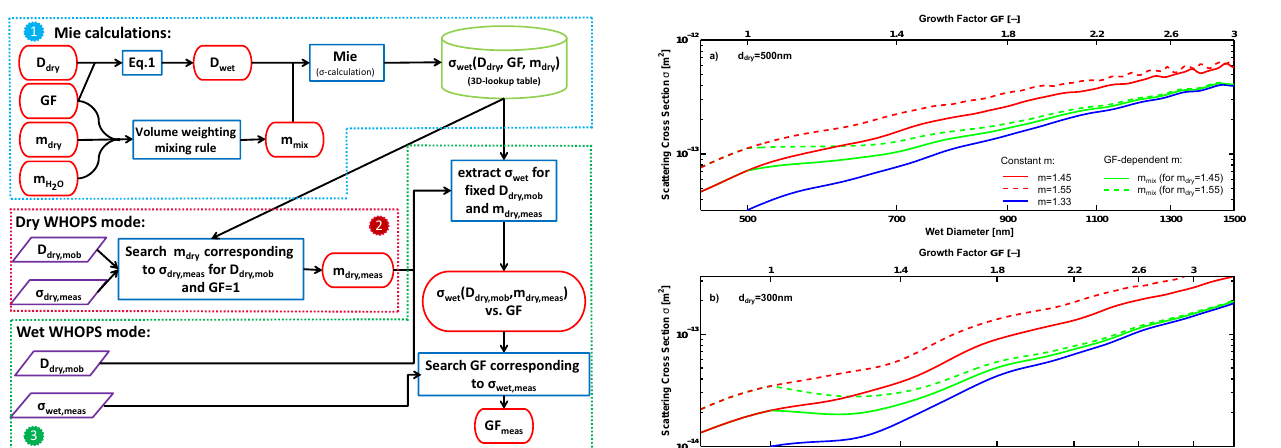
the size-selected particles at high RH. The hygroscopic wa- ter uptake gradually reduces the index of refraction of the solution droplets with increasing size (GF). The scattering meaningful size (GF meas ) by using the lookup table and the